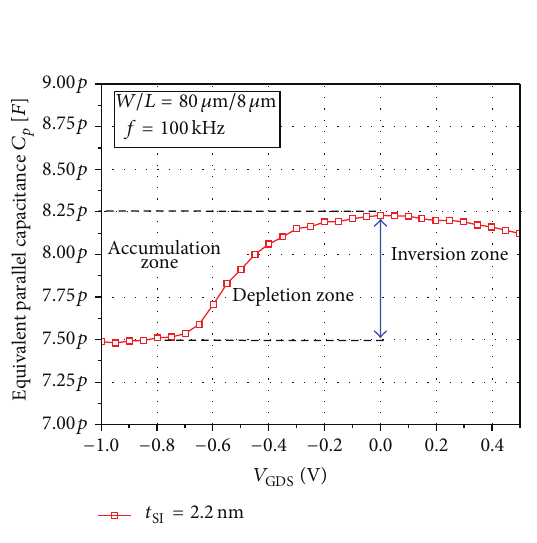
Figure 6: Parallel mode 𝐶 𝑃 - 𝑉 characteristics for GRC with GDS 2.2 nm channel film thickness. The device has the same gate 𝑊 × 𝐿 = 80 × 8 𝜇 m 2 = 6.4 × 10 −6 cm 2 . The capacitance 𝐶 𝑃 was measured at 100 kHz. Drain and source are shorted.